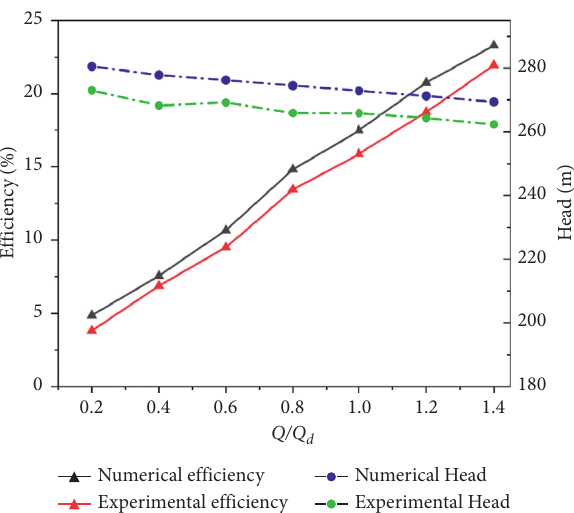
Figure 2: Pressure pulsation monitoring point settings ( P -1– P -6, volute and tongue; P -7– P -10, impeller passage).